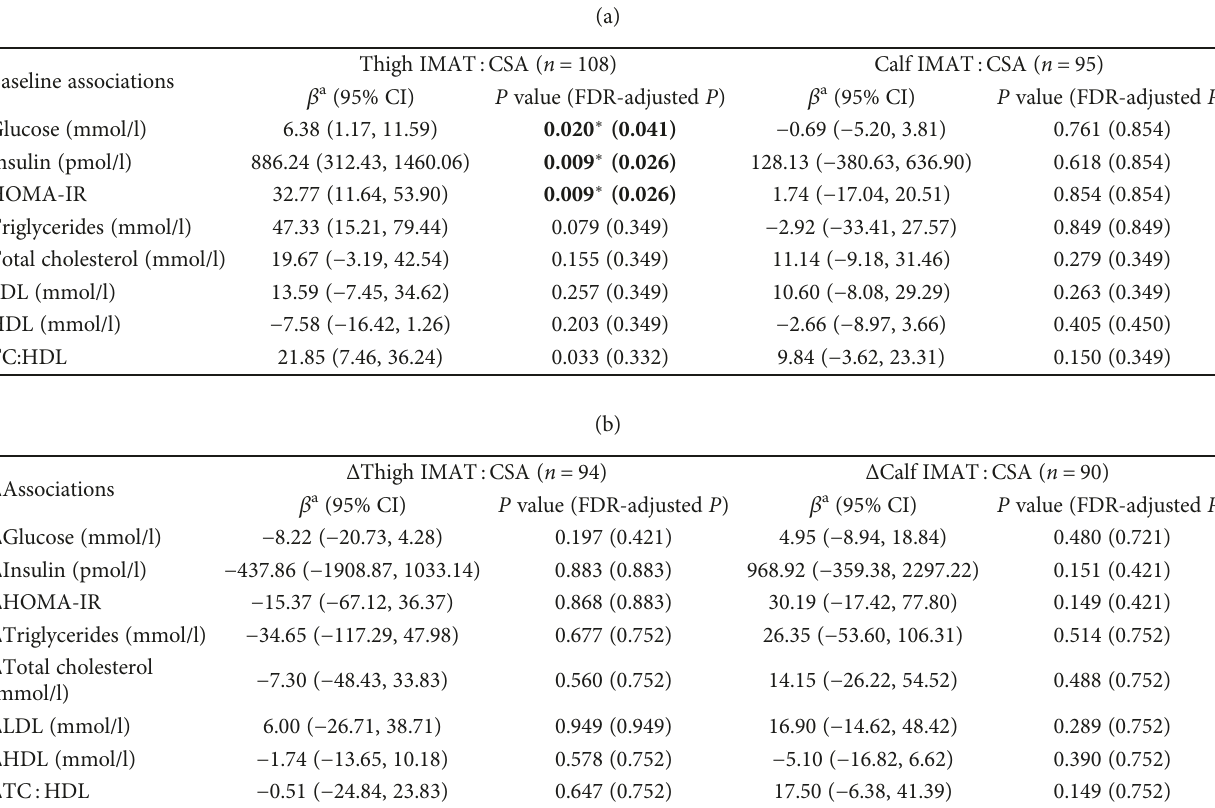
Table 3: Associations between thigh or calf intermuscular adipose tissue and indices of cardiometabolic